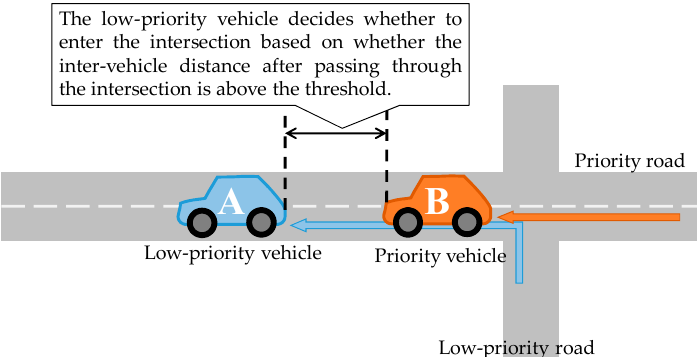
Figure 6. Concept of the inter-vehicle distance based on which the low-priority vehicle decides whether to enter the intersection.